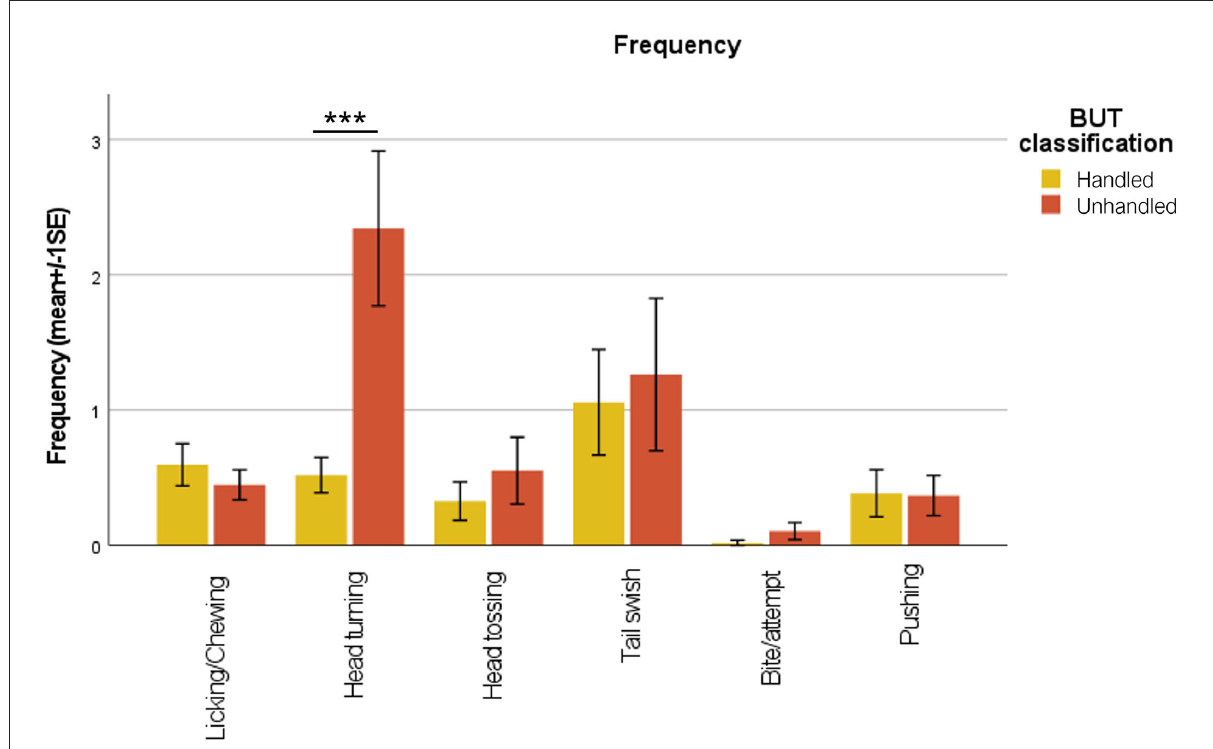
FIGURE4 Mean frequencies referred to behaviors recorded as events. Mann–Whitney test; *** p <